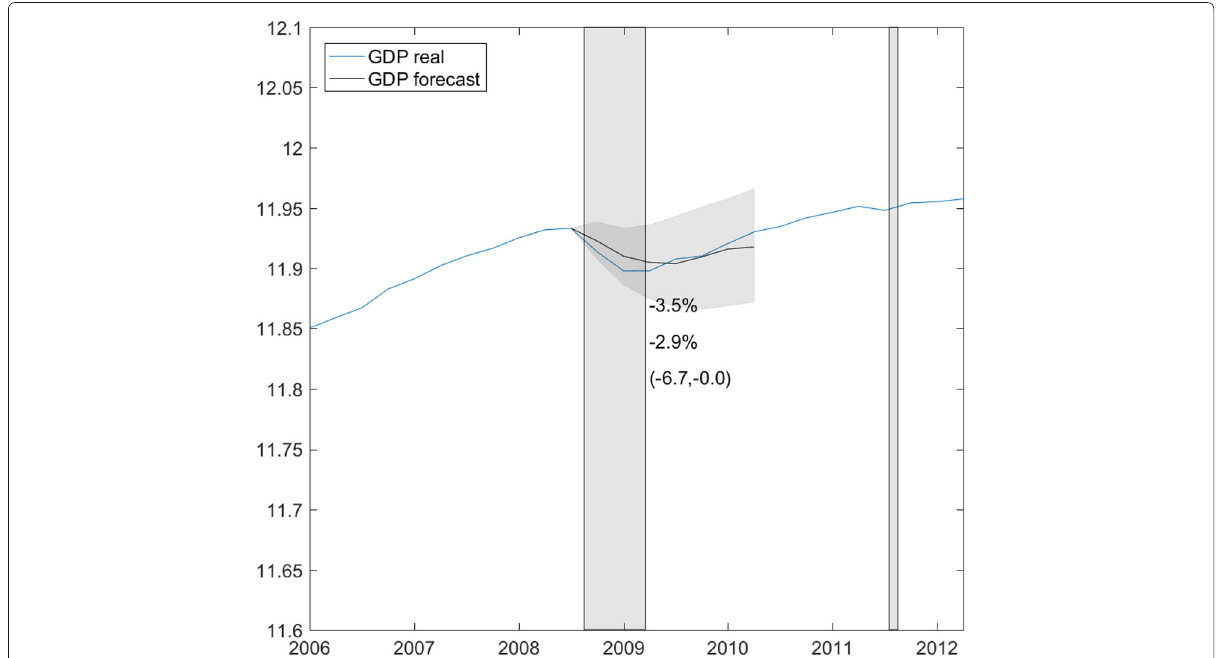
Fig. 7 Out-of-sample GDP forecast, mean level forecast with 95% highest forecast density interval in gray. Sample period: second quarter 2001–third quarter 2008. Model estimated using as prior information posterior moments obtained for the long-sample estimate. Forecast period: fourth quarter 2008–third quarter 2010. Gray bars highlight the financial crisis and the introduction of the euro-Swiss franc